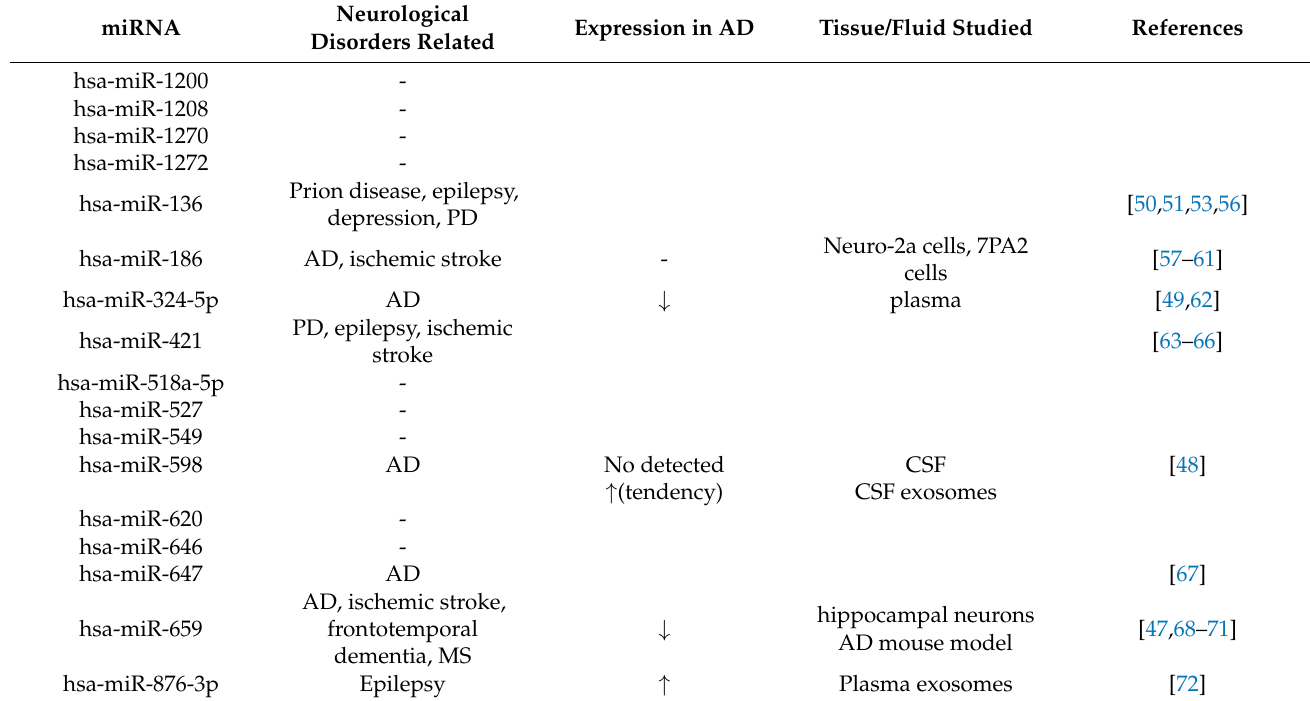
Table 2. miRNAs predicted to bind circAPP (hsa_circ_0007556) with circInteractome tool and their implication in neurological disorders. Expression in AD Tissue/Fluid